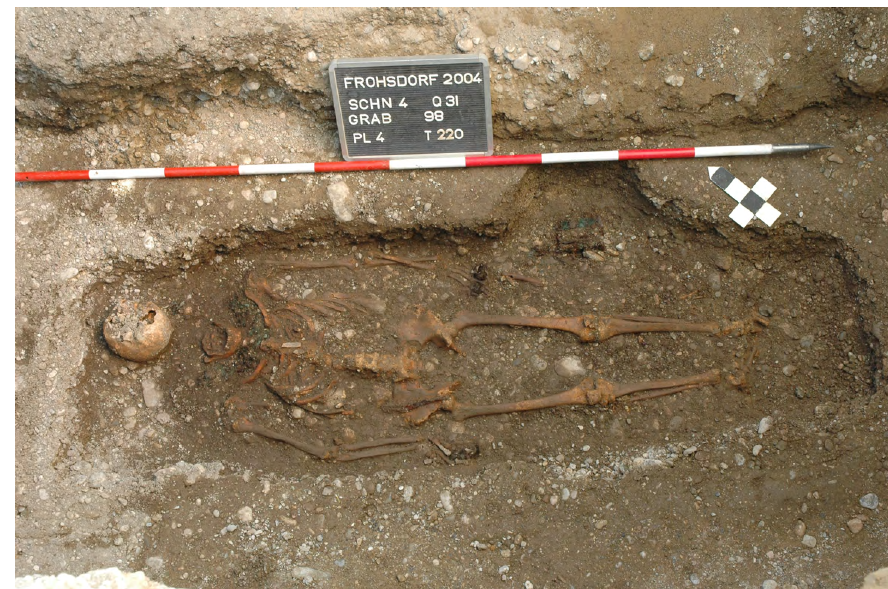
Figure 1a: Grave 98 with rolled off skull (photo: Bendeguz